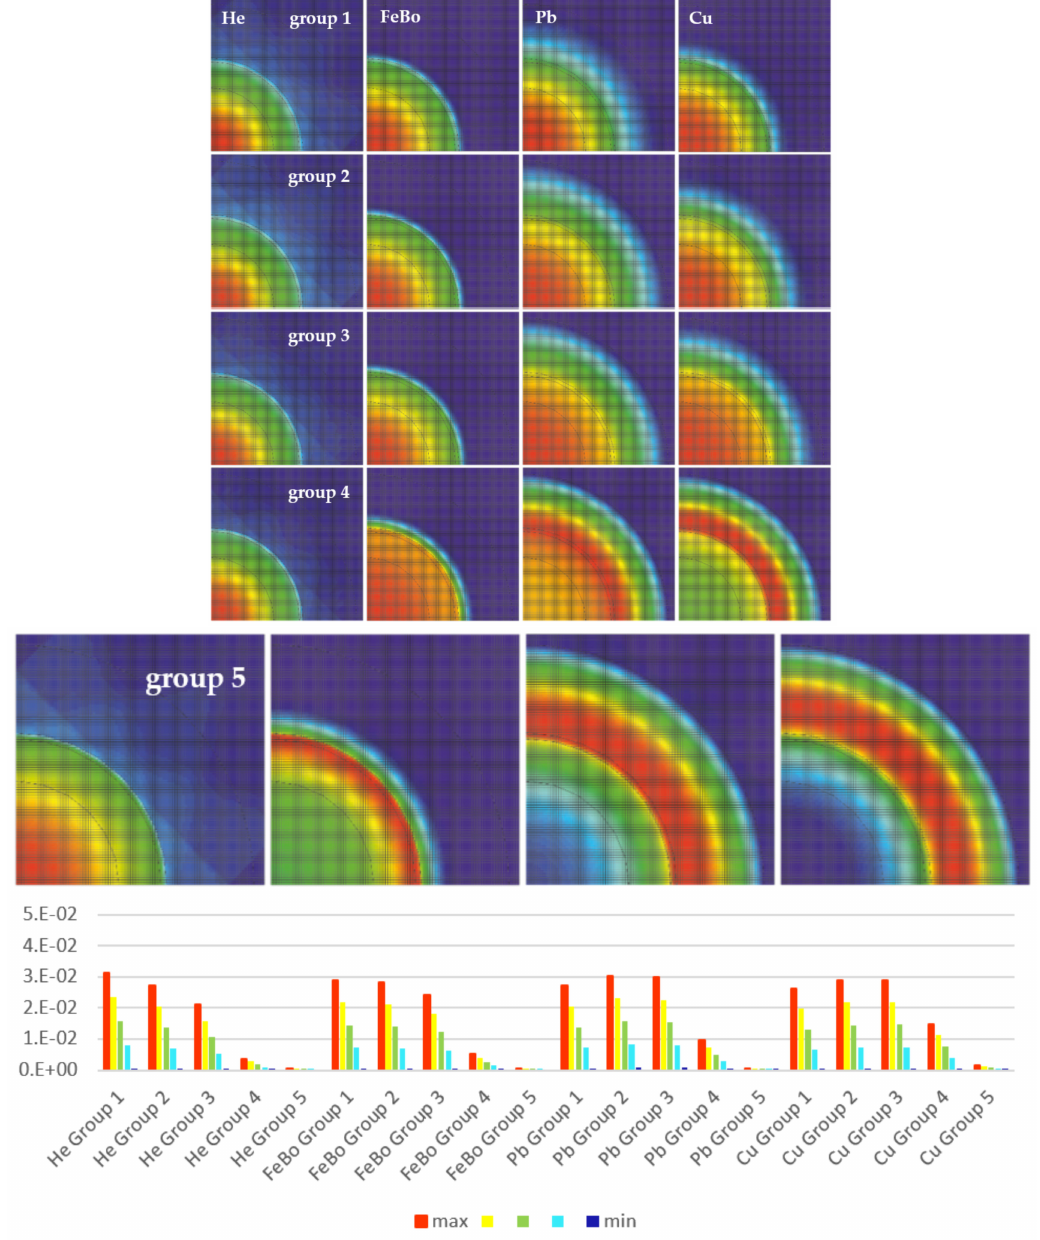
Figure 14. Groupwise 2D spatial neutron flux distribution in the core for four different weakly reflecting